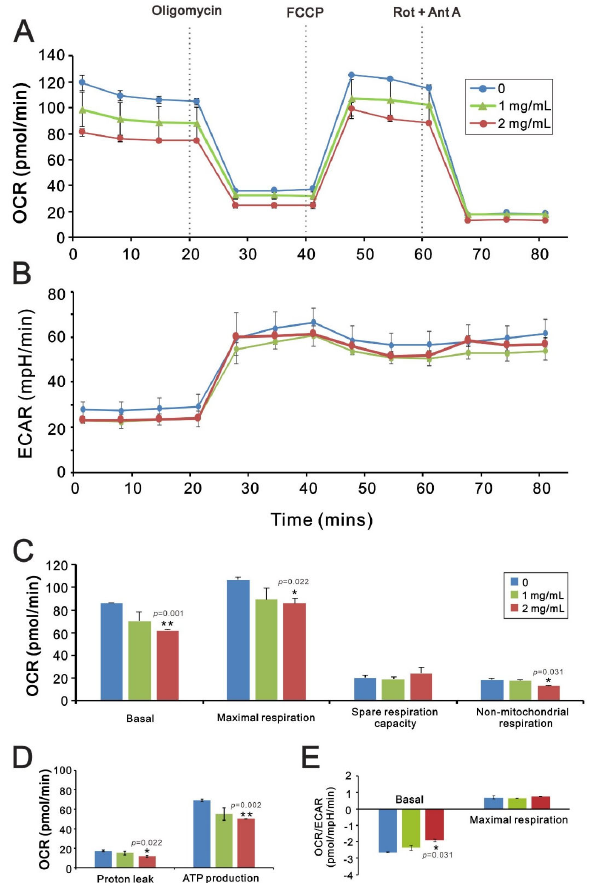
Figure 8. Effects of T. mongolicum on the oxygen consumption rate (OCR) and extracellular acidification rate (ECAR) in MDA-MB-231 cells. ( A – D ) MDA-MB-231 cells were treated for 24 h with the indicated concentrations of T. mongolicum , after which cellular OCR ( A , C , D ), ECAR ( B ), and the OCR/ECAR ratio ( E ) were measured in XF24 bioenergetic assays. Symbols and bars depict the mean ±SD. * p < 0.05, ** p < 0.01.